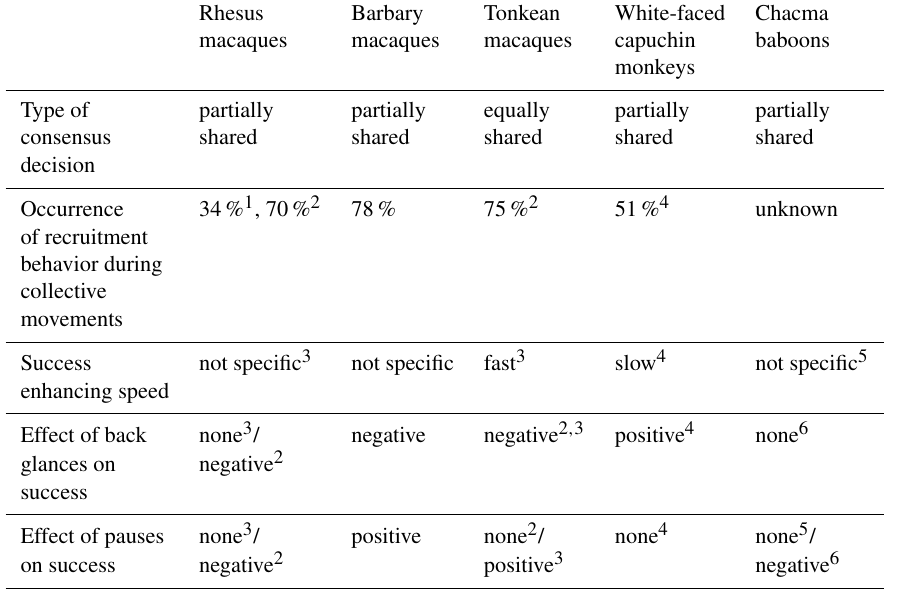
Table 3. Comparative data on Barbary macaques (this study, wild group), rhesus macaques (semi-free-ranging conditions), Tonkean macaques (semi-free-ranging conditions), white faced capuchin monkeys (semi-free-ranging conditions) and Chacma baboons (wild group). Rhesus